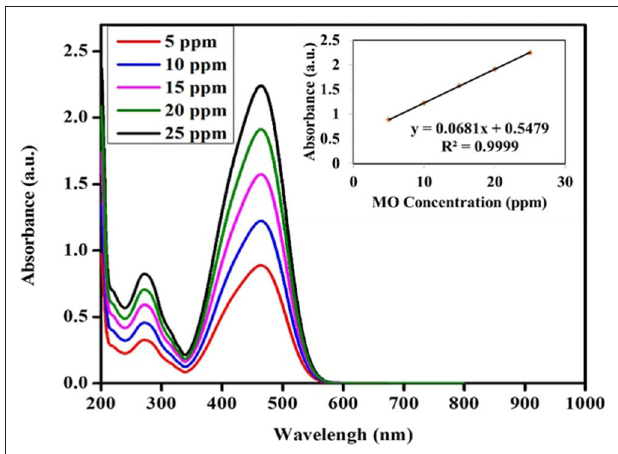
FIGURE 2 | Calibration curve spectra and line graph of M.O. Solution.